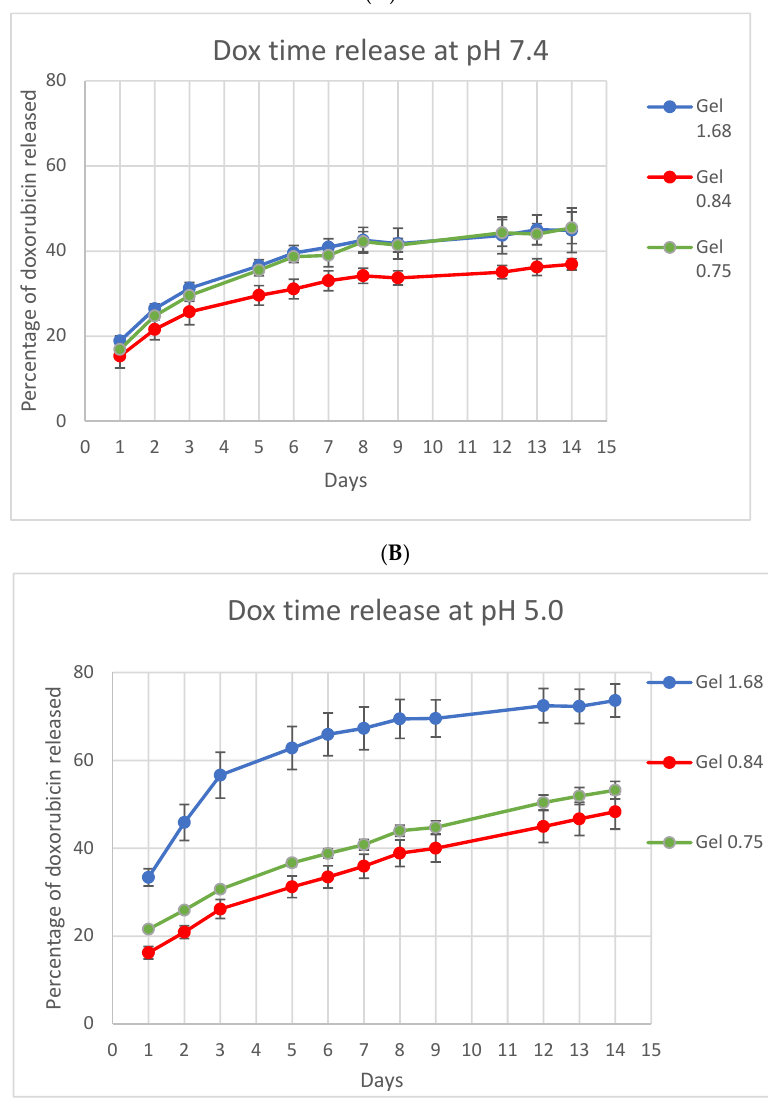
Figure 3. In vitro doxorubicin release from ELP hydrogels with different collagen concentrations. ( A ) At pH 7.4 the three ELP hydrogels had very similar release profiles. ( B ) At pH 5 release from the lowest collagen concentration gel was both accelerated and enhanced. Experiment was conducted at 37 °C. Error bars represent bounds of 95% confidence interval.